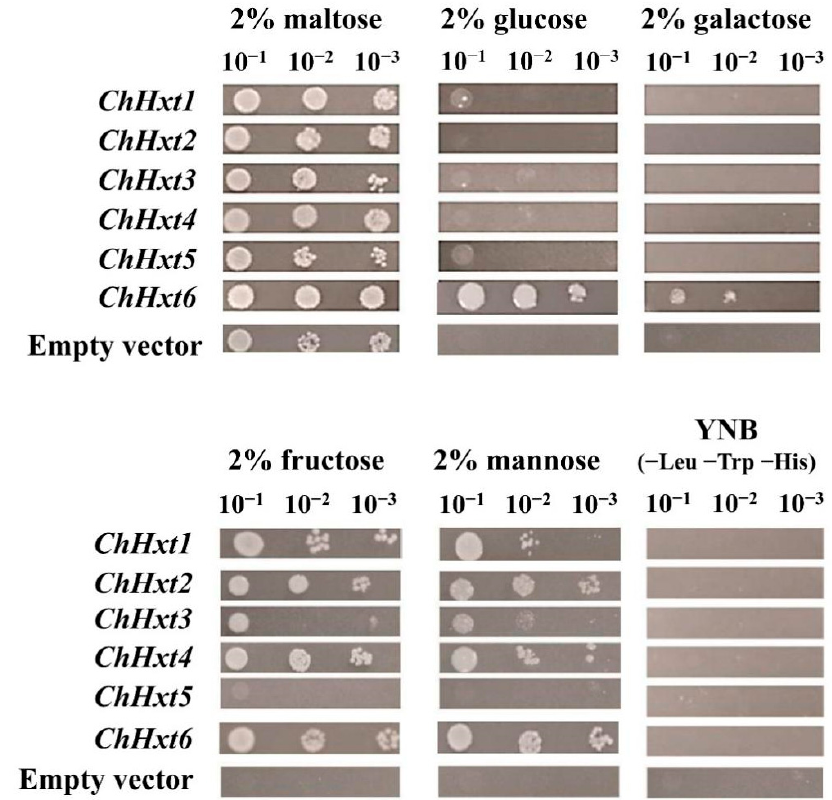
Figure 4. Growth of the Saccharomyces cerevisiae strain EBY.VW4000 (lacking all 20 identified hex- ose transporters) and modified EBY.VW4000 strains expressing different ChHxt genes (ChHxt1 to ChHxt6). Expression of ChHxt genes complemented the growth defect of EBY.VW4000 on YNB media supplied with different monosaccharides. Growth of yeast was observed and recorded after incubation at 28 ◦ C for three